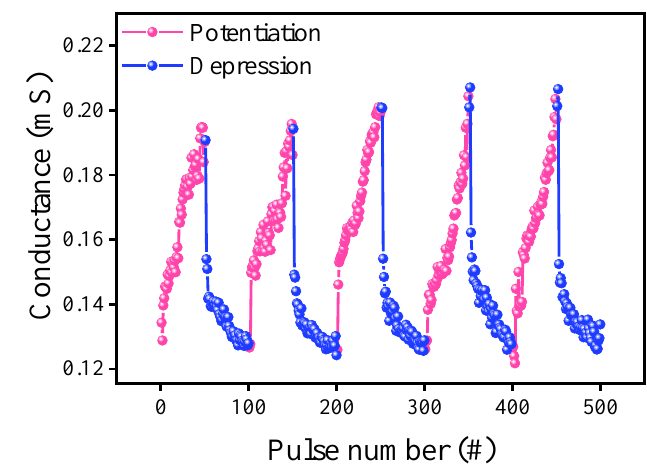
Figure 5. ( a ) Pulse settings used for the potentiation and depression measurement. ( b ) Conductance changes during the 500 consecutive identical pulses.